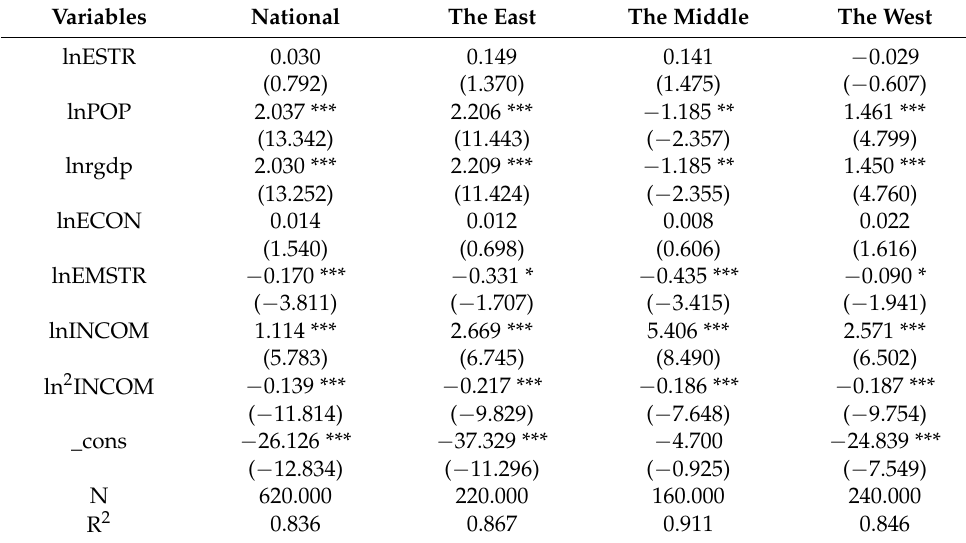
Table 5. The impact of consumption structure on carbon